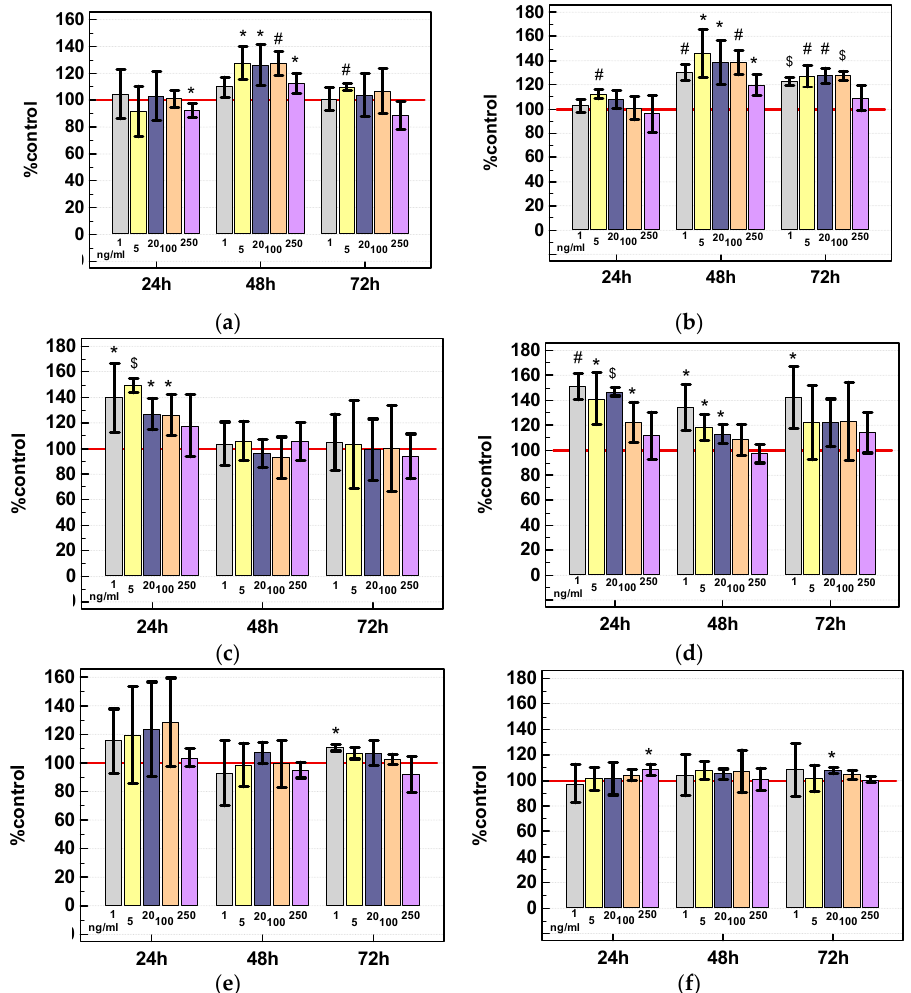
Figure 14. Effect of exogenous IL-13 (1–250 ng/mL) on cancer cell viability under normal (10% FBS) and nutritional-stress (0.5% FBS) conditions as determined with sulforhodamine B (SRB) assay: ( a ) HCT 116 cultured in 10% FBS; ( b ) HCT 116 cultured in 0.5% FBS; (c ) HT-29 cultured in 10% FBS; ( d ) HT-29 cultured in 0.5% FBS; ( e ) Caco-2 cultured in 10% FBS; ( f ) Caco-2 cultured in 0.5% FBS. Data presented as percentage (% control) of viability of unstimulated cells, marked at 100% as reference red horizontal line. Statistically significant differences in treated cells as compared to their respective controls, analyzed using t -test for one mean, are marked as follows: p < 0.05 as *; p < 0.01 as #; p < 0.001 as $. Bars represent means ± SE of at least three experiments. FBS, fetal bovine serum. Gene Expression Increased cell viability may result from accelerated proliferation or increased resistance to apoptosis. Therefore, potential IL-4 and IL-13 effect on expression of genes encoding representative